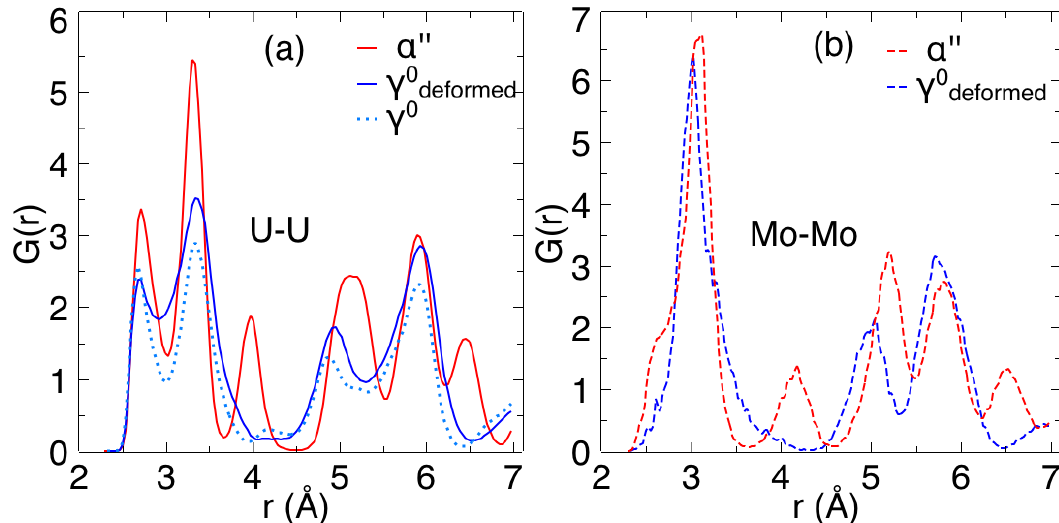
Figure 6. Calculated pair distribution functions for different U–10 at.% Mo alloy structures: ( a ) Three dependencies of G U - U ( r ) at room temperature: α (cid:48)(cid:48) -phase and γ 0 deformation and non-deformed γ 0 -phase. ( b ) Two dependencies of G Mo - Mo ( r ) at room